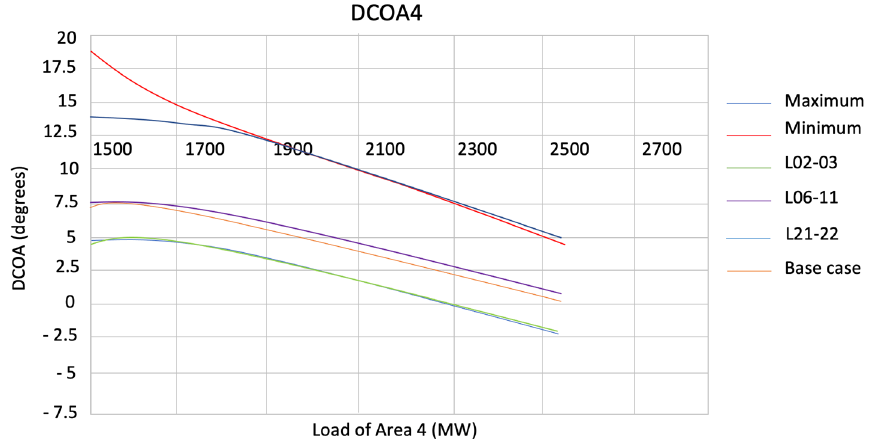
Figure 13. Angular characterization for contingencies N-1 in operational area 4.